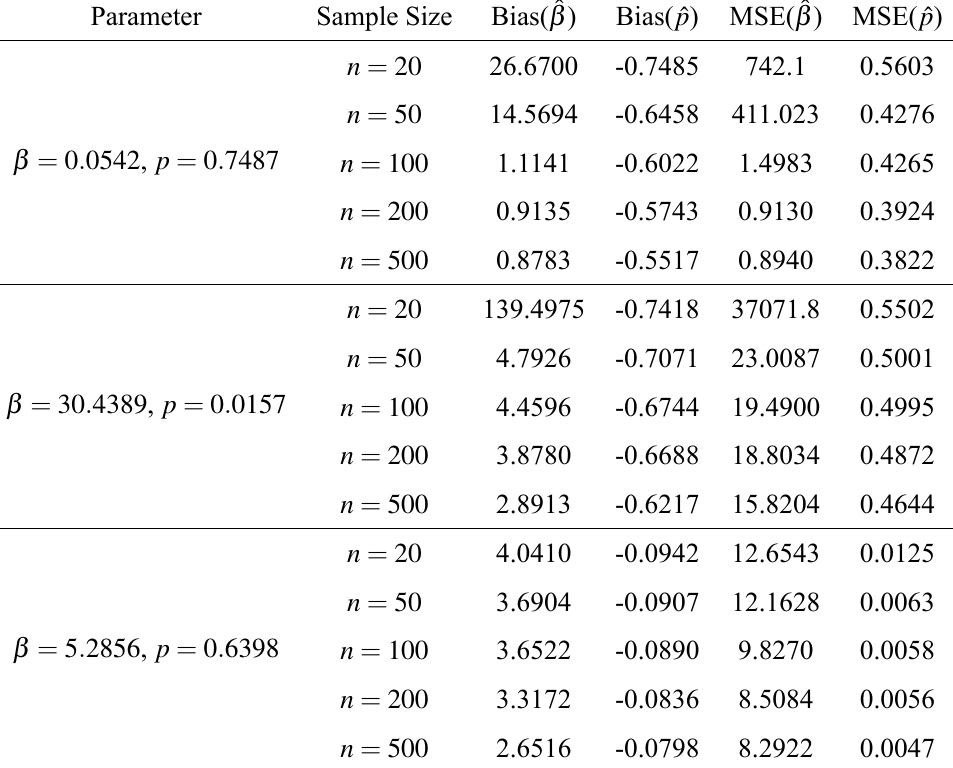
Average Bias and MSE values of the MMEs from simulation of the WNBL